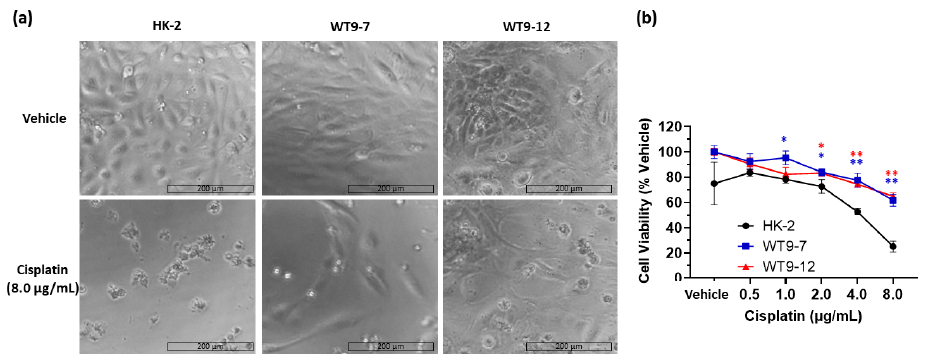
Figure 4. Effect of cisplatin treatment on human ADPKD cells (WT9-7 and WT9-12) compared to control (HK-2) cells. ( a ) Cell morphology under light microscope showing decreased cell density and necrosed HK-2 cells compared to WT9-7 and WT9-12 cell lines with 8.0 µg/mL cisplatin treatment; ( b ) Quantitative measurement of cell viability using the MTT assay showing significantly reduced cell viability in HK-2 cells compared to WT9-7 and WT9-12 cells at similar doses of cisplatin. * p < 0.05; ** p < 0.01 compared to HK-2 cells at respective doses with the color of asterisk matching line color. Scale bar = 200 µm.